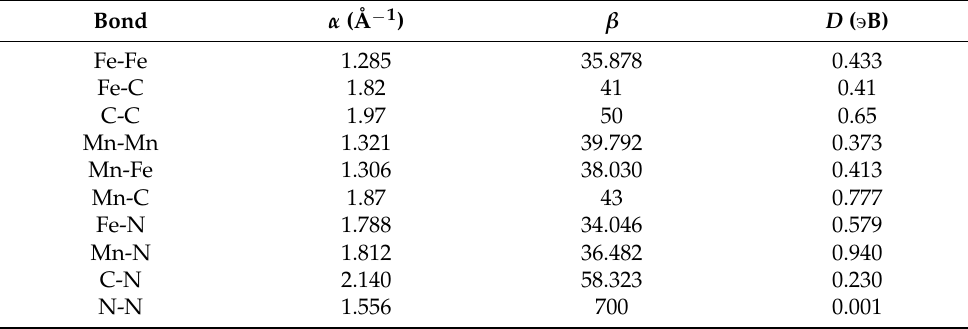
Table 3. Parameters of Morse potentials for the considered